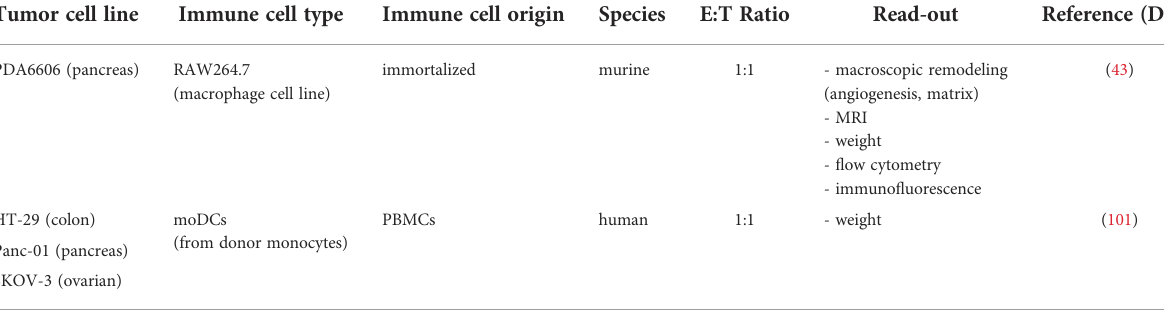
TABLE 3 Studies that focused on tumor-immune cell interactions in ovo